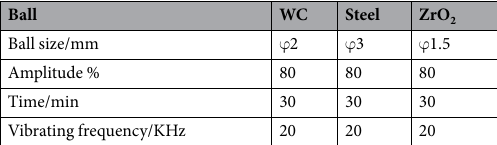
Table 1. SMAT processes for the WL10 plate.